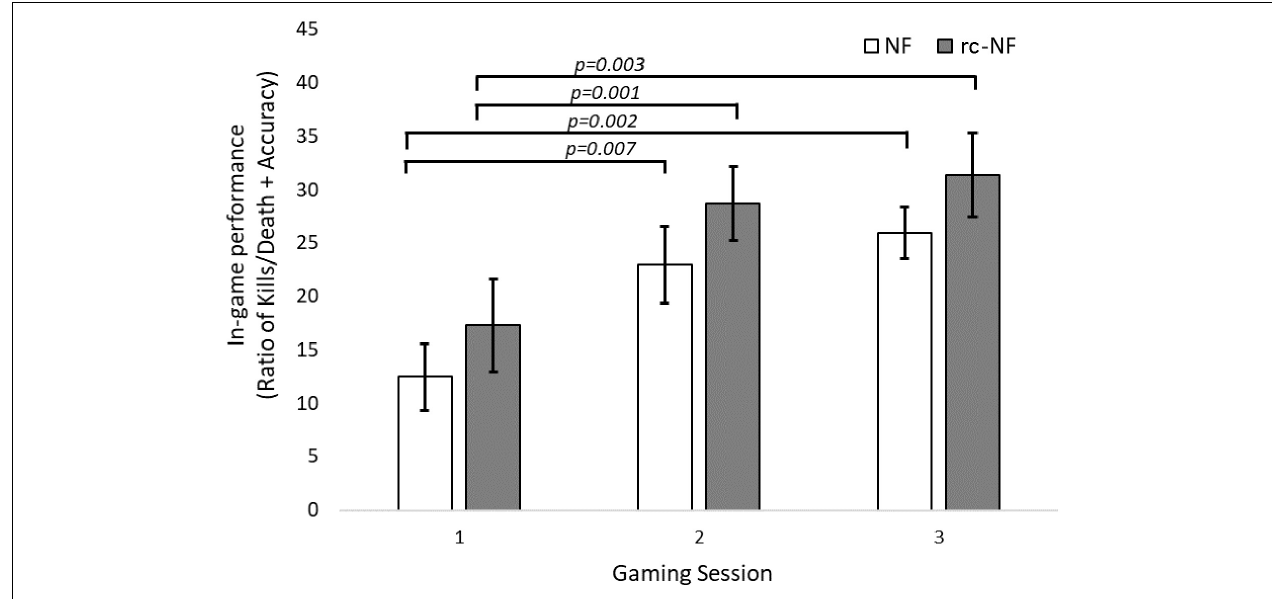
FIGURE 5 | Gaming performance over three gaming sessions shows a learning curve (Ritter and Schooler, 2001). Participants improve over time while still performing NF-based regulation via cognitive